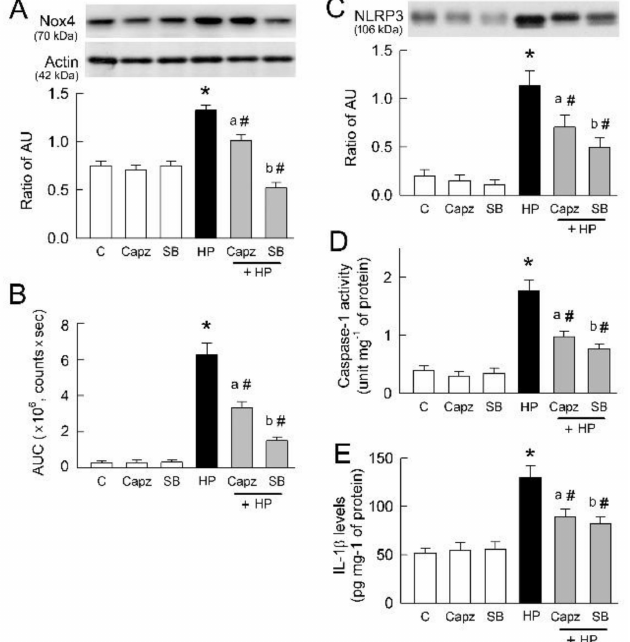
Figure 8. Chronic TRPV1 inhibition attenuates hyperoxaluria-induced oxidative stress and inflamma- tion on day 14. ( A ) Representative blots show expression of Nox4 using 10 µ g of total protein in each group. Lower bar graph shows densitometrically quantified results by ratio of Nox4 to actin (n = 6 per group). ( B ) Bar graph shows total chemiluminescence (CL) counts for superoxide formation in kidney surface as area under the curve (AUC) for n = 6 in each group. Note that TRPV1 inhibition significantly attenuates oxidative stress in HP kidney. ( C ) Representative blots show expression of NLRP3 using 10 µ g of total protein in each group. Lower bar graph shows densitometrically quantified results by ratio of NLRP3 to actin at 8A (n = 6 per group). ( D ) Bar graph showing caspase-1 activity measured in tissues of renal cortex in group. ( E ) Quantitative results showing increased tissue content of IL-1 β in group (n = 6 per group). Note that TRPV1 inhibition significantly attenuates renal inflammation caused by hyperoxaluria. * p < 0.05, HP vs. control (C) group. a p < 0.05, Capz + HP group vs. HP group; b p < 0.05, SB + HP group vs. HP group; # p < 0.05, blocker-treated vs. untreated HP group. One-way ANOVA was applied for statistical comparison in all